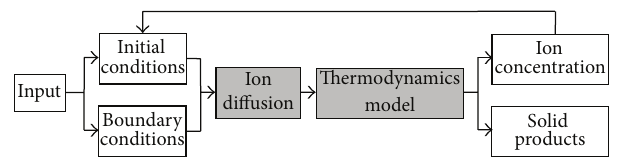
Figure 4: Flowchart of the model for further hydration